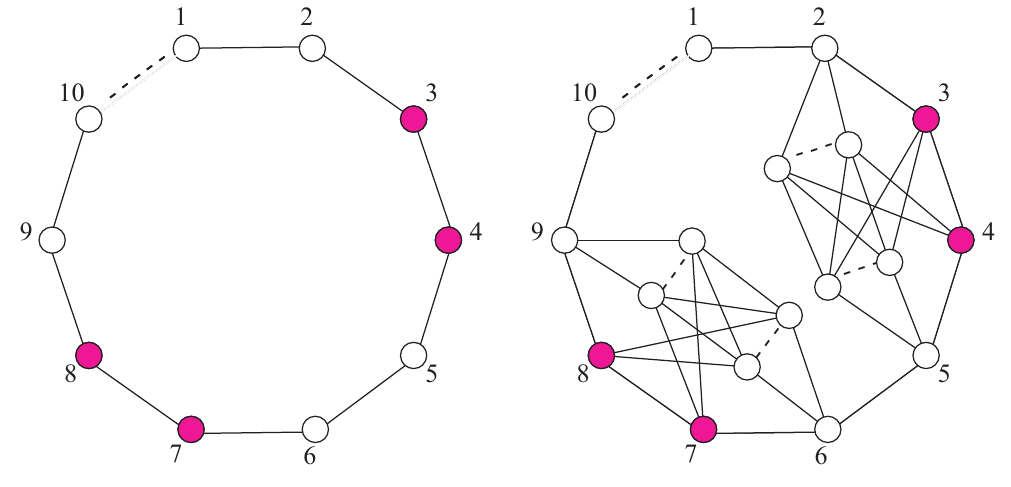
Figure 7: C 4 s before and after twinning (pink vertices selected for twinning)